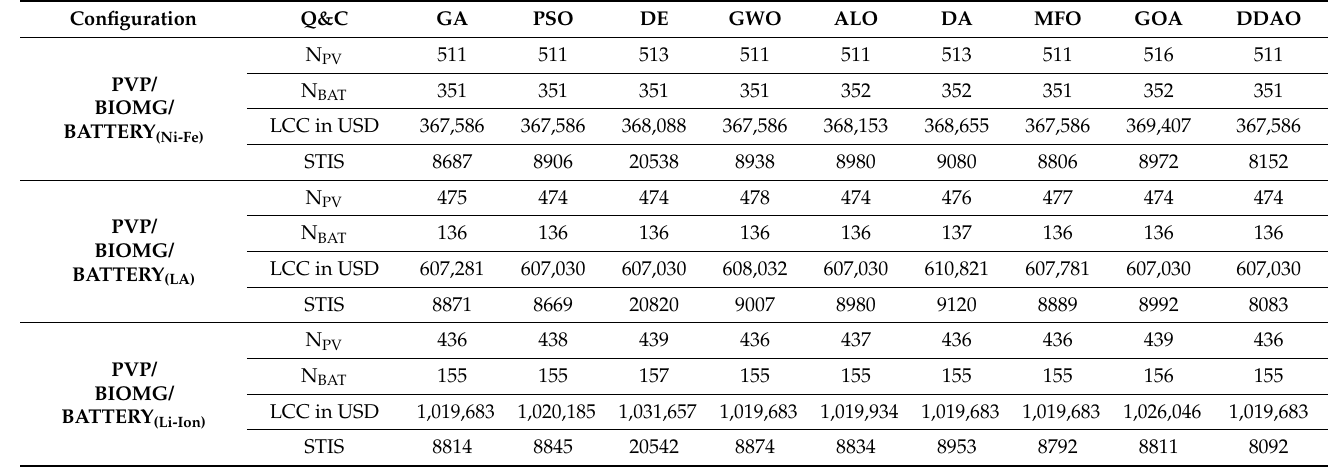
Table 4. Optimization results of all configurations at an LPSP value of